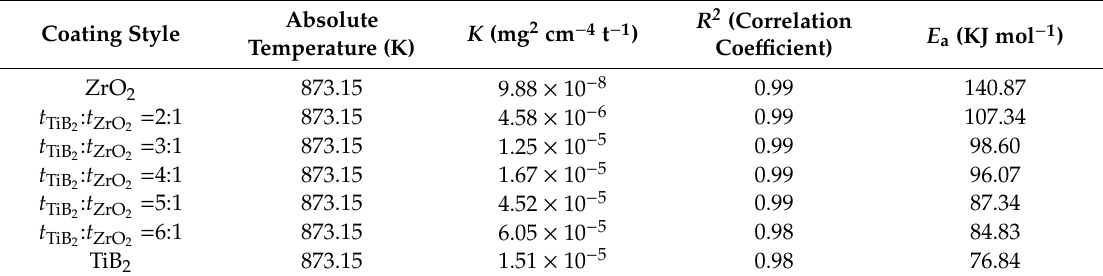
Table 1. The calculated K , R 2 and E a (activation energy) values of TiB 2 , ZrO 2 monolayers and TiB 2 / ZrO 2 multilayers tested at 600 ◦ C,